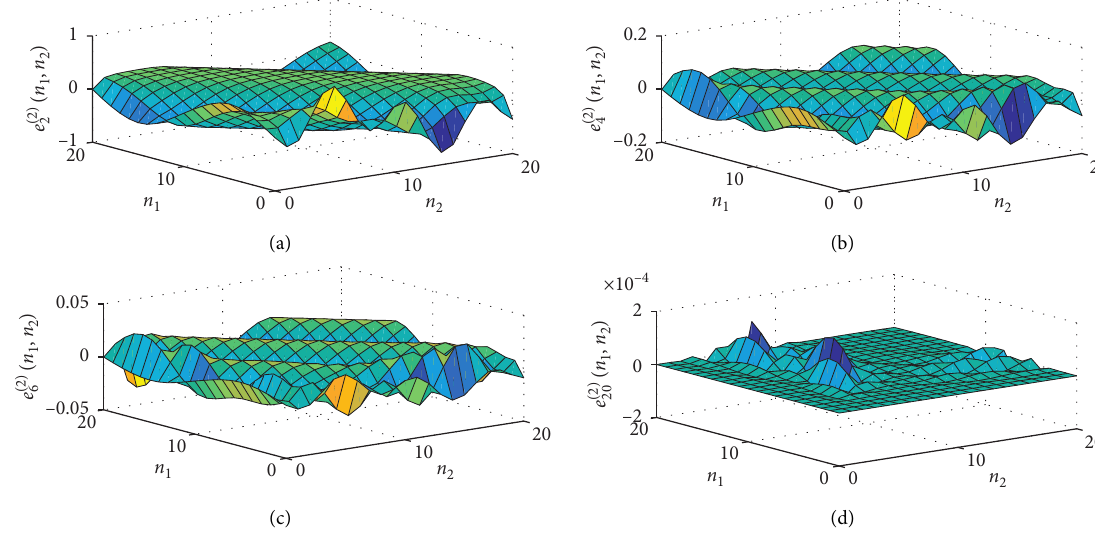
Figure 3: Tracking error surface e ( 2 )